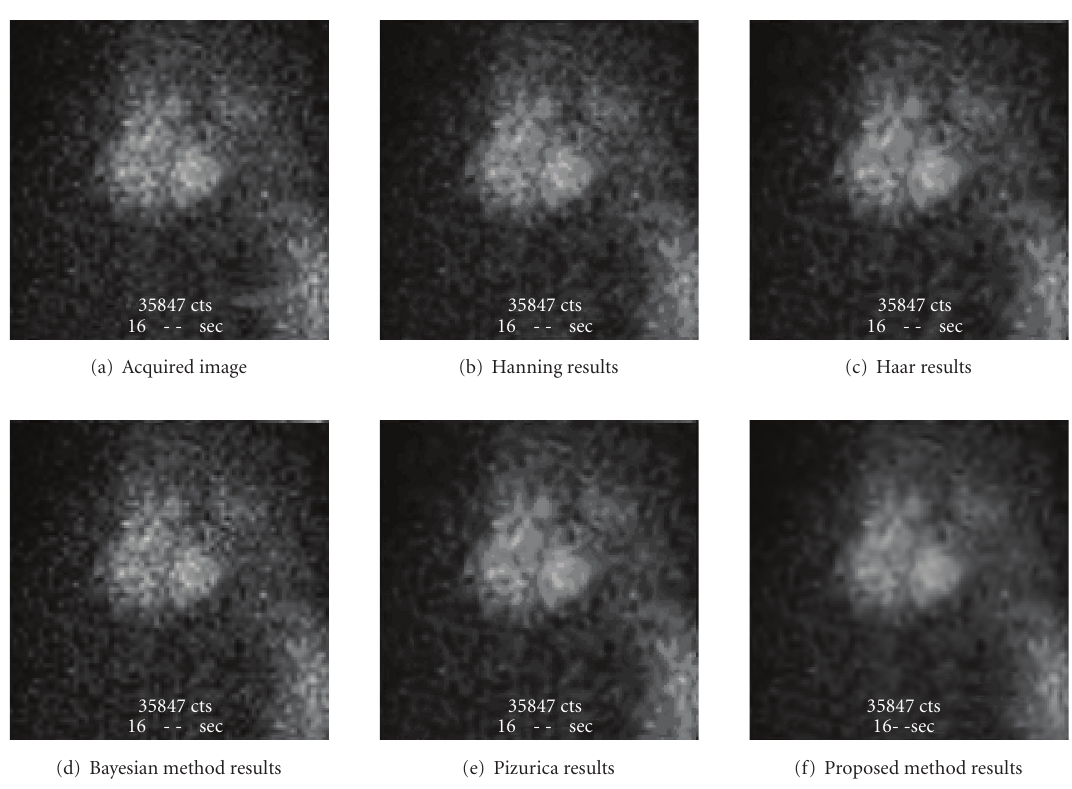
Figure 5: Comparison of the method with several other methods, on a heart scintigraphic